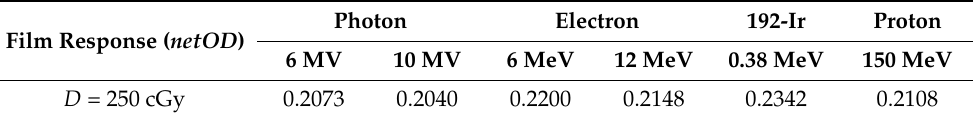
Table 4. Values of 𝑛𝑒𝑡𝑂𝐷 at 250 cGy for standard Gafchromic ™ EBT3 films. Table 4. Values of netOD at 250 cGy for standard Gafchromic ™ EBT3